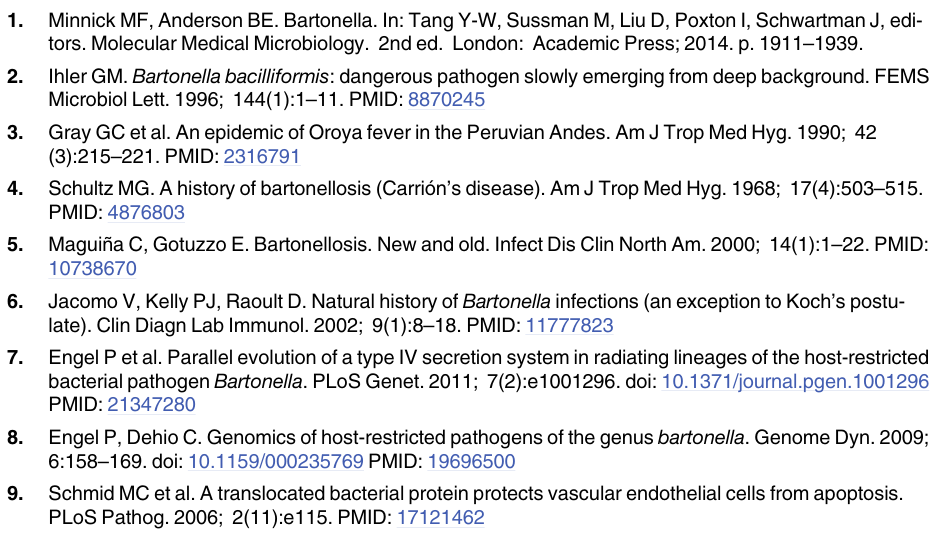
S1 Table. RAST annotated genes in strain-specific prophage region of Cond044. This region represents position 779373 bp to 815728 bp of acOtG-supercont1.2.C7 supercontig in the whole genome shotgun sequence of Cond044. S2 Table. List of core recombinant genes. Gene annotations are based on the reference strain KC583. S3 Table. List of core phage genes predicted by PHAST. Gene annotations are based on the reference strain KC583. S4 Table. List of genes with truncation mutations in one or multiple strains. Gene annota- tions are based on the reference strain KC583. S5 Table. List of candidate non-recombinant core genes with adaptive convergent muta- tions in B . bacilliformis subspecies I. Gene annotations are based on reference strain KC583. Amino acid positions accumulating convergent mutations are shown. Genes representing enriched (or overrepresented) functional clusters are